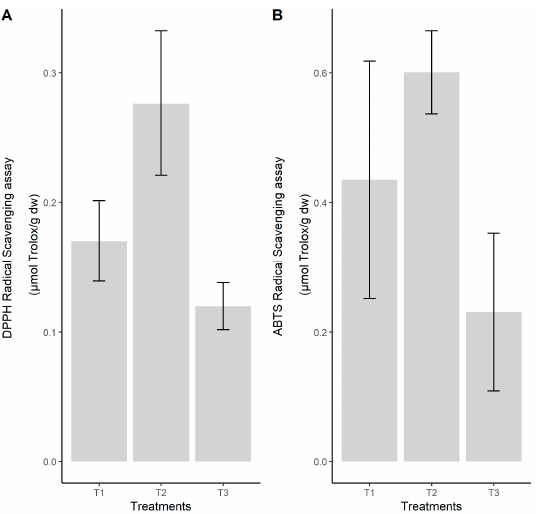
Figure 2. Inhibition percentage (%) and µmol Trolox equivalent per gram of dry weight fungi ma- terial, according to the substrate used in the cultivation of P. ostreatus : ( A ) DPPH radical scavenging